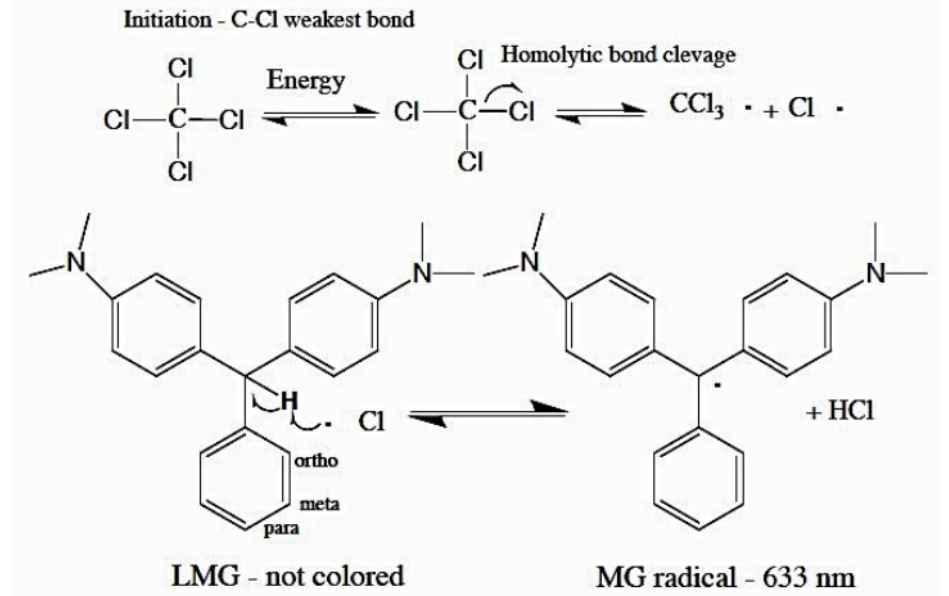
Figure 1. A mechanism for color formation in TAM (LMG) color former.